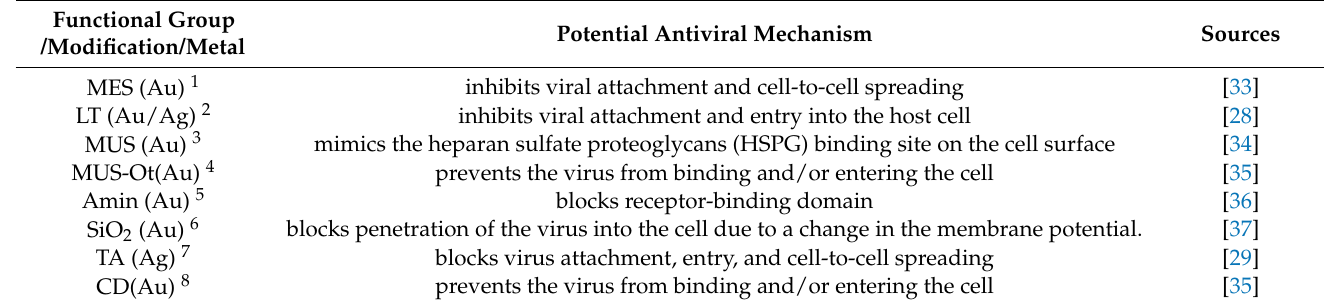
Table 1. Antiviral mechanism by functionalized gold or silver nanoparticles.